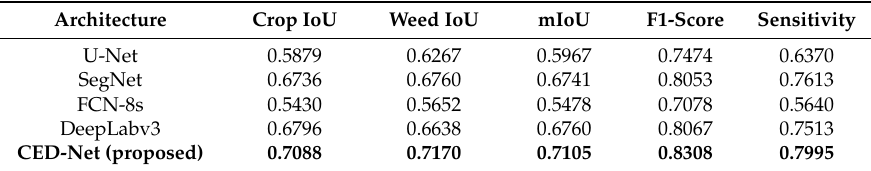
Table 3. Comparison of evaluation metrics for rice seeding and weed dataset (bold number represents the best results in the